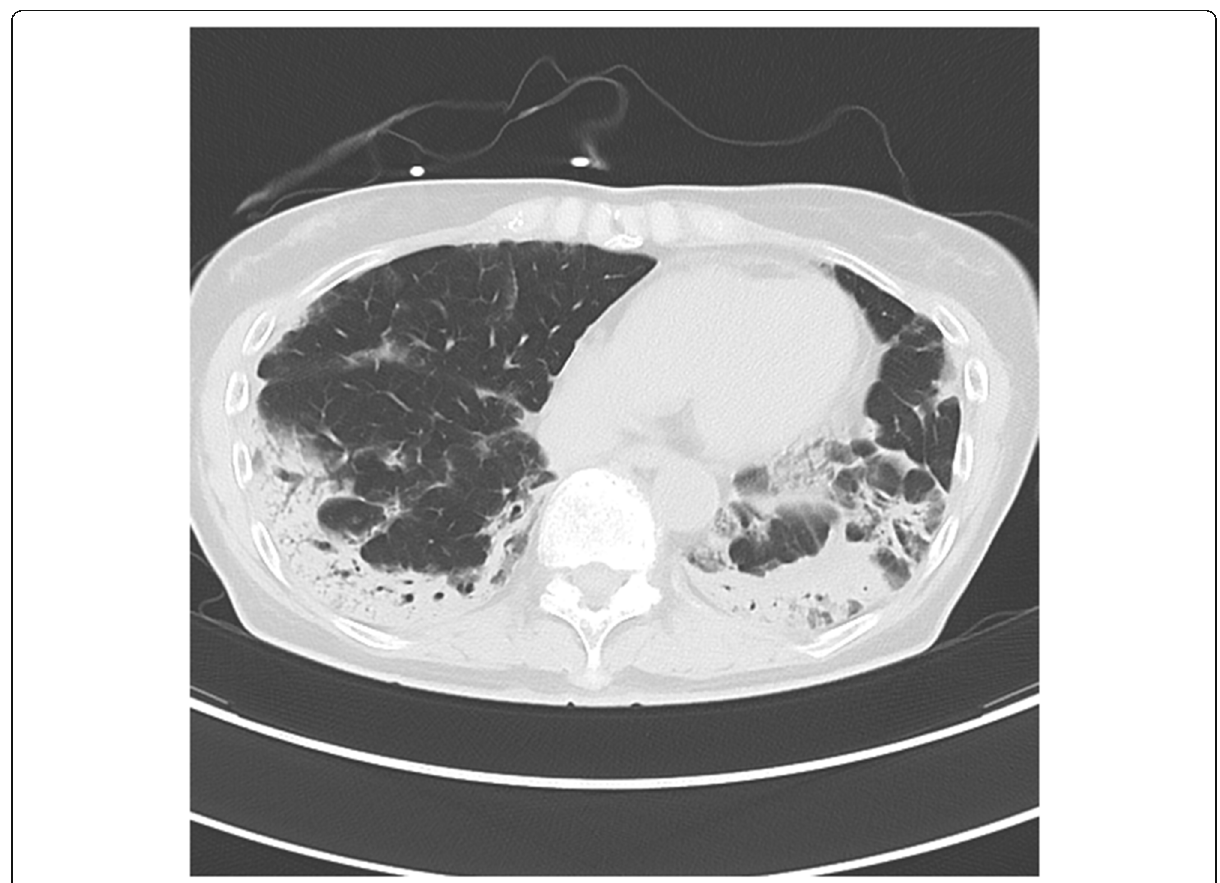
Fig. 1 Initial chest computed tomography (CT) showed bilateral and peripheral predominant consolidation and air